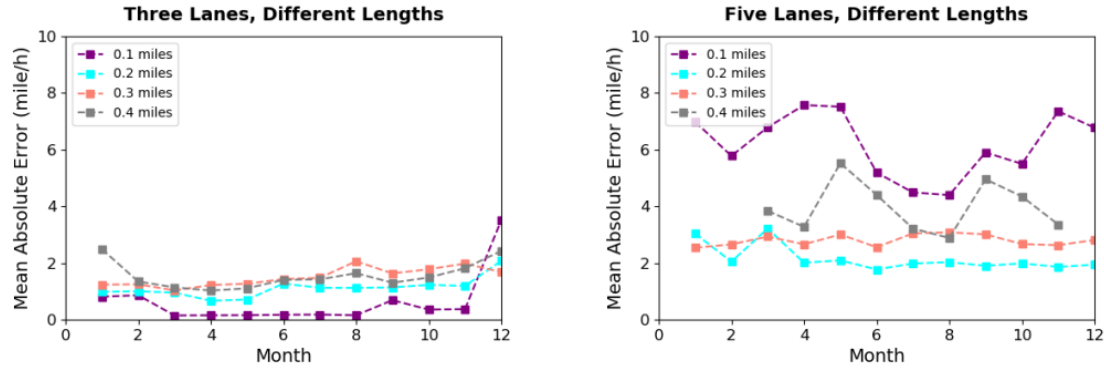
Figure 13. 3-lane series and 5-lane